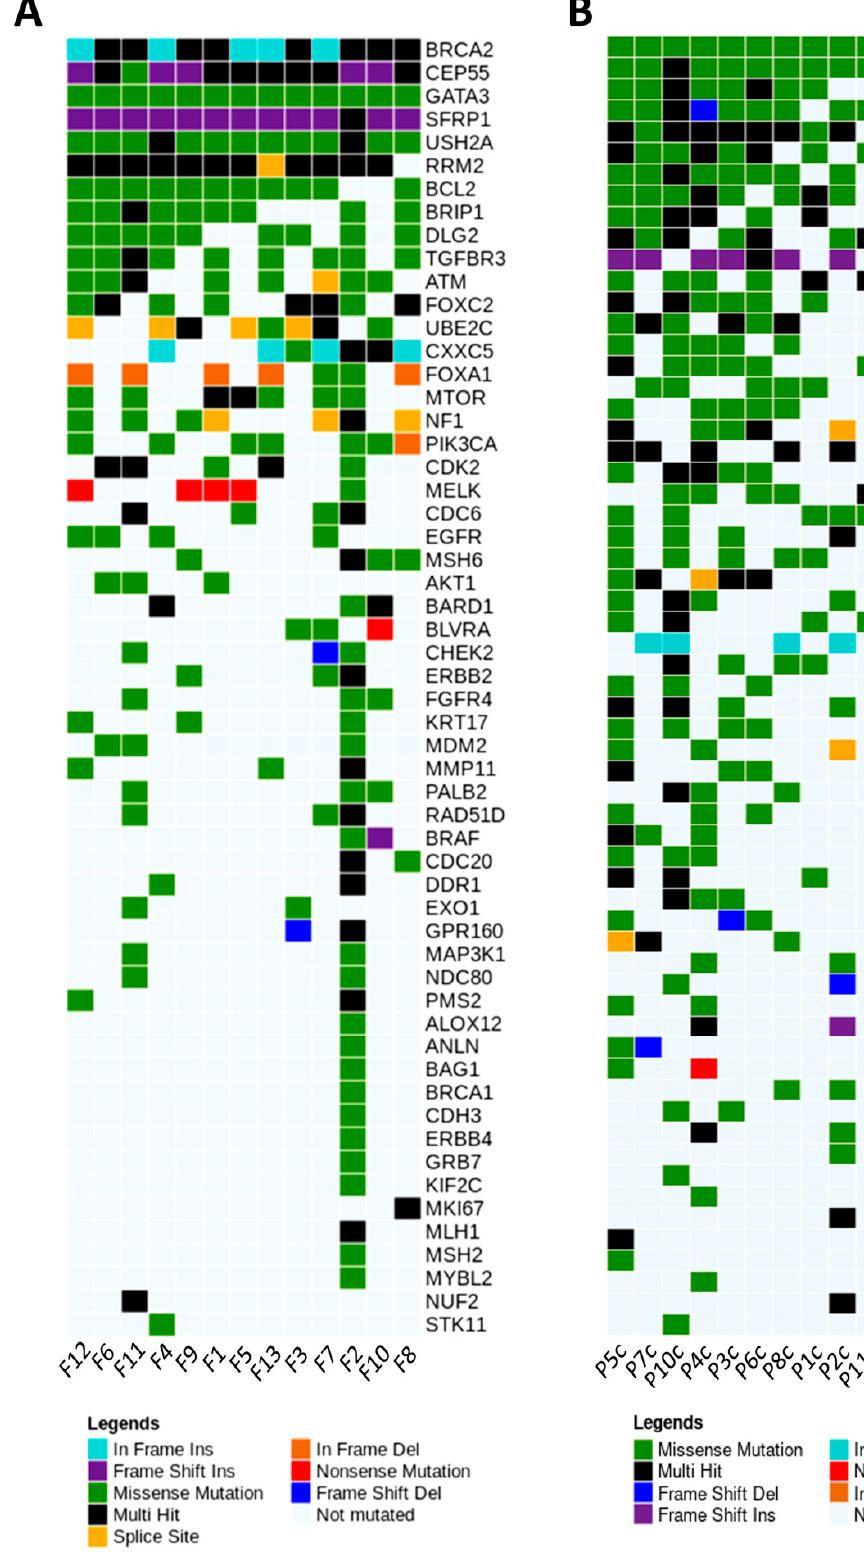
Figure 8. Oncoplots depicting the distribution of most representative variants in BC-associated mutated genes regarding the individual tumor fragments ( A ) and plasma samples ( B ) of dogs. The plots exhibit the mutations in each tumor sample (most deleterious mutation types are shown). Graphics were generated from the R language, using the Maftools package.